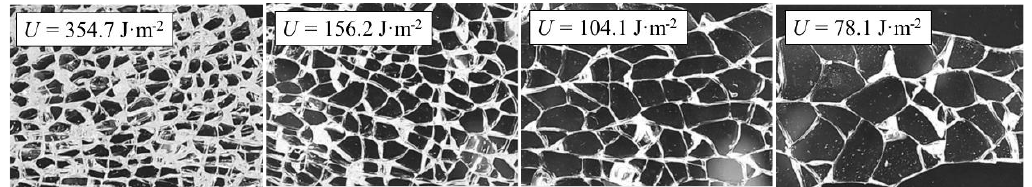
Fig. 1 Fracture morphology of thermally tempered glass having various elastic strain energy (Pourmoghaddam et al. 2018).